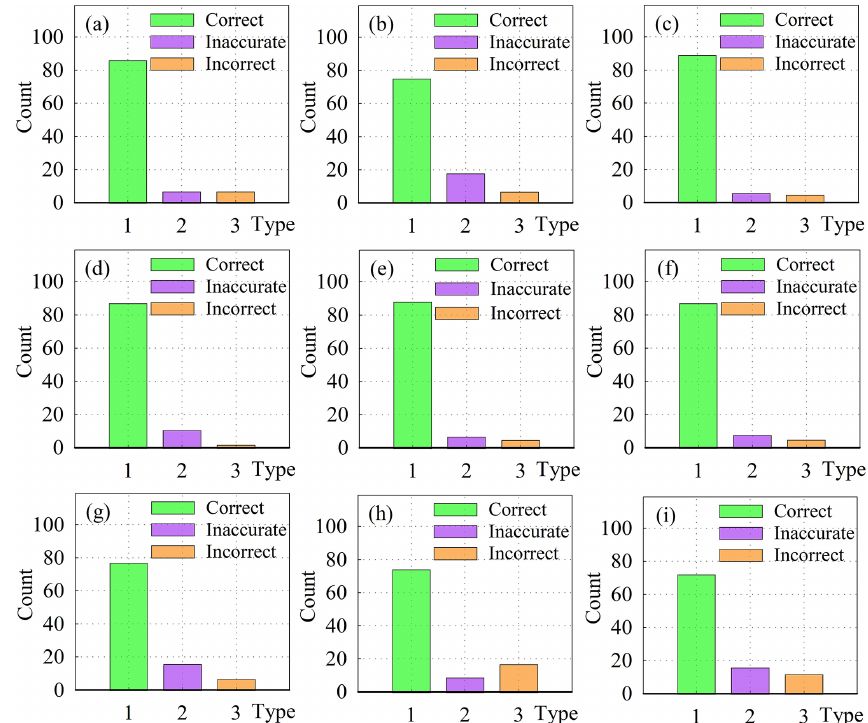
Figure 9. The statistical chart of evaluating results according to the first-level